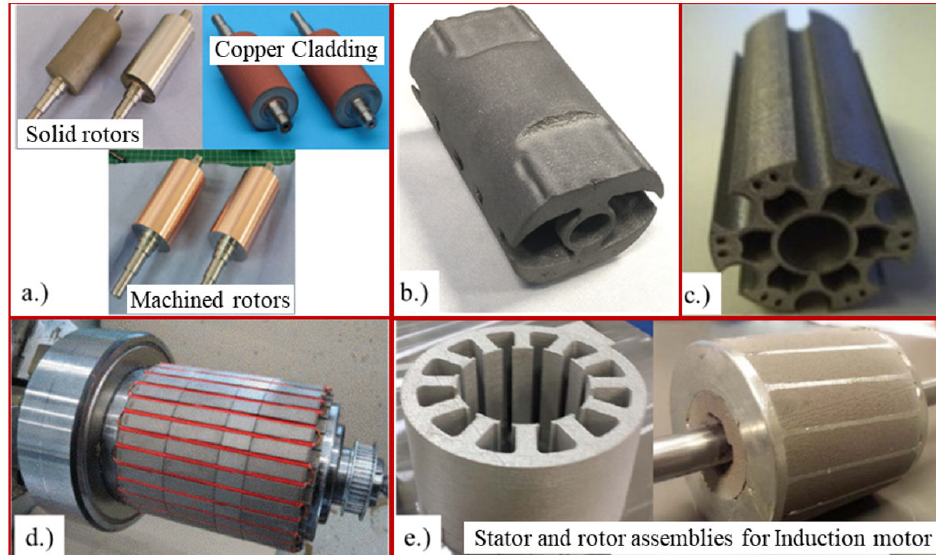
Figure 1. Examples of AM-built cores ( a ) solid steel rotor with copper cladding for usage in electric vehicles-Rolls Royce Central Technology [33] ( b ) PM rotor with optimized torque density [34] ( c ) prototype rotor for switched reluctance machine [16,26] ( d ) lightweight rotor utilizing lattice structure topology, for PM synchronous machine [35] ( e ) stator and rotor assemblies of an induction machine for automotive applications [36].